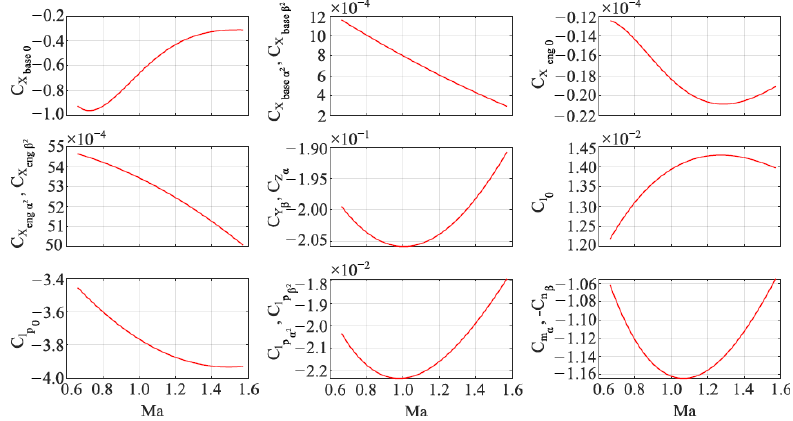
Figure 2. Aerodynamic